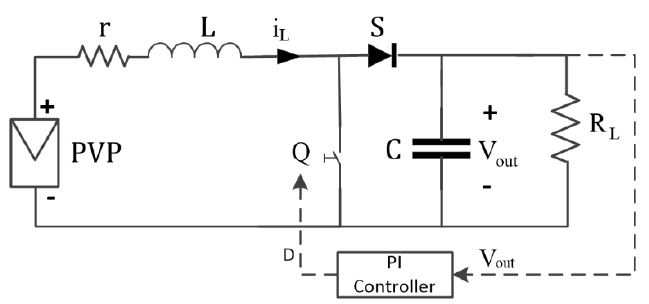
Figure 6. DC-DC PEC with a proportional integral (PI) controller.